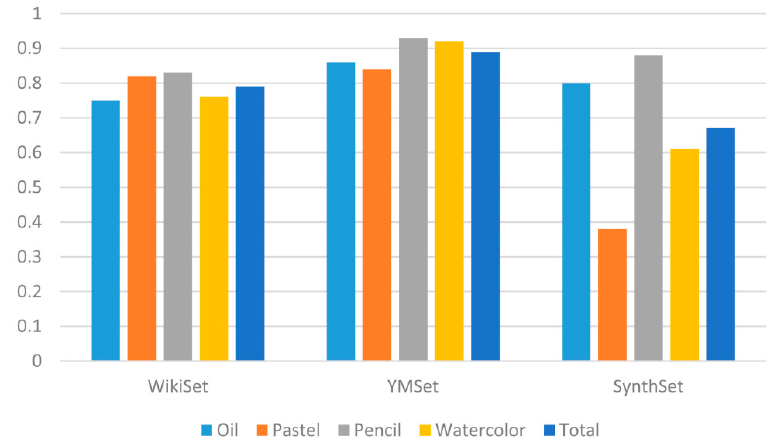
Figure 10. Comparison of F1 scores from three datasets on our recognizer. Figure 11. The decreasing order of recall values of the confusion matrices in Figure 8 for YMSets and SynthSet .